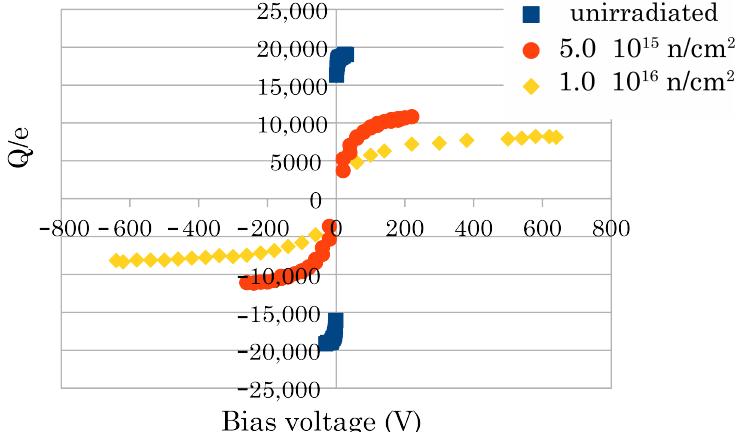
Figure 4. Measured charge vs. bias voltage for the 500 col/mm 2 sensor (S-curves). We expressed the charge in the number of electrons, i.e., normalized the collected charge value by the elementary charge e . The allowed maximum voltage increases with the irradiation fluence (see text).